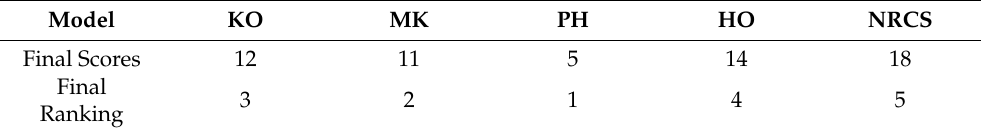
Table 5. Overall ranking of the evaluated soil infiltration models for TWW irrigated soils at JUST.